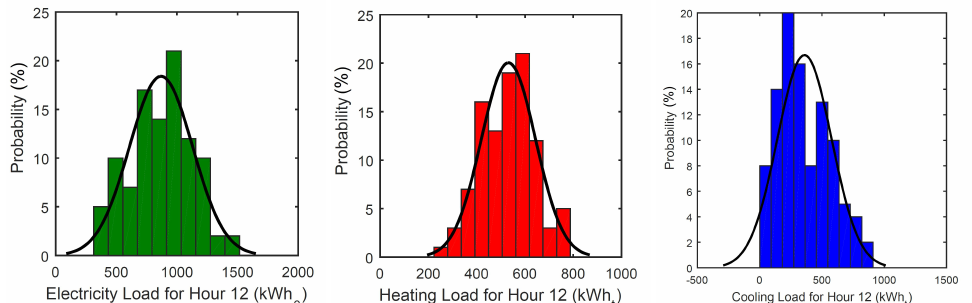
Figure 18. Probability of electricity load ( left ), heating ( center ), and cooling load ( right ) of the 12th hour on 21 June.